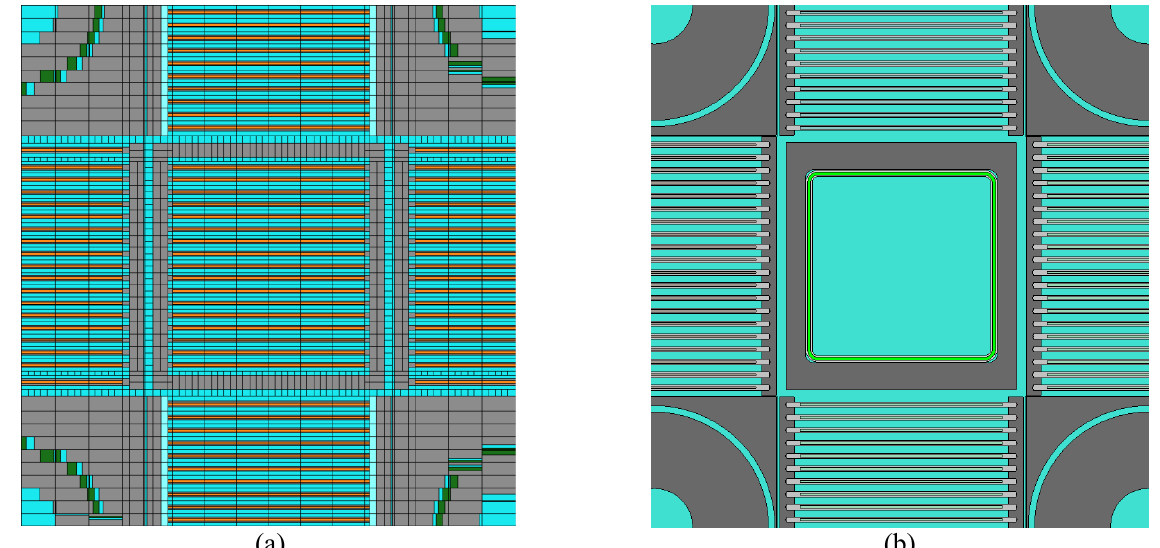
Figure 2. Extended 3x3 lattice environment used to generate homogenized cross sections for the fuel follower (a) and cadmium absorber section (b) of the control